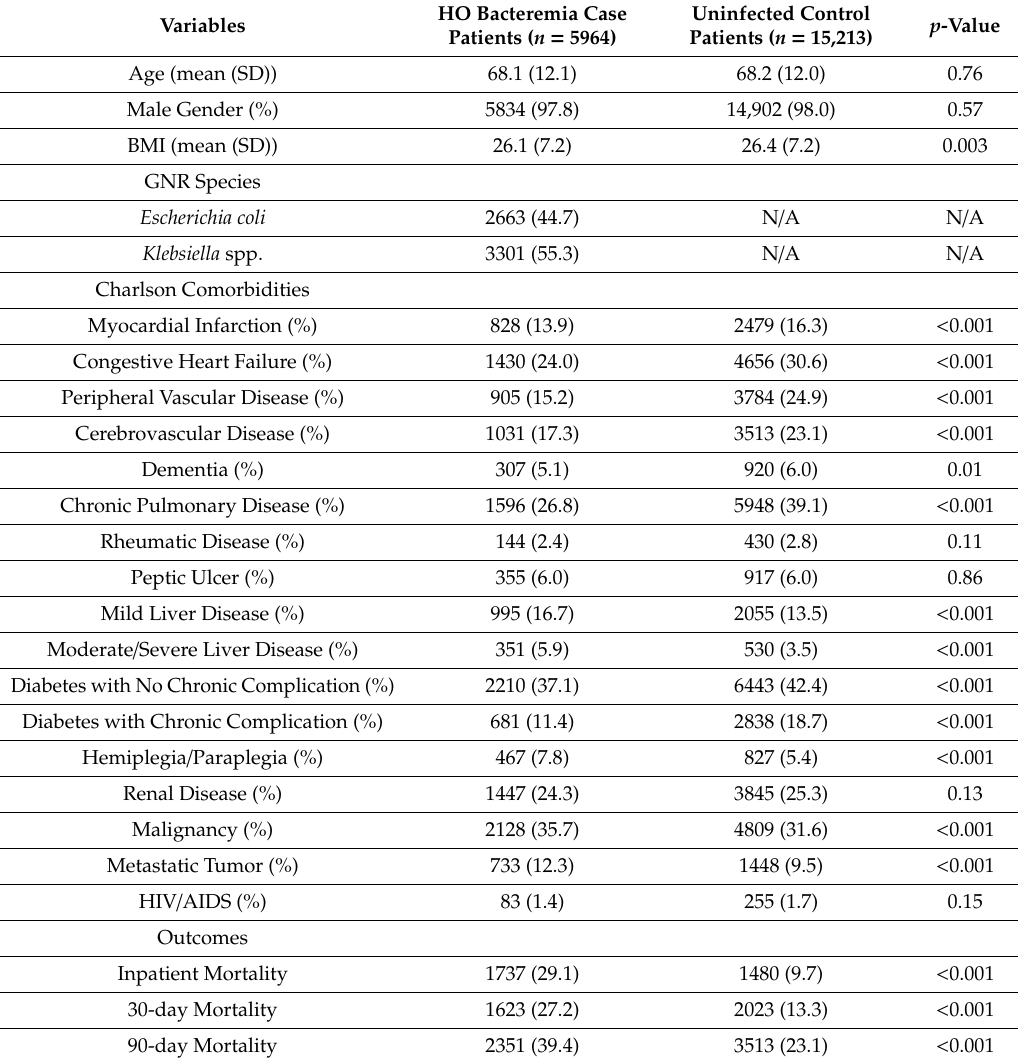
Table 1. Characteristics of cohort patients and uninfected control patients (2003–2013). Variables